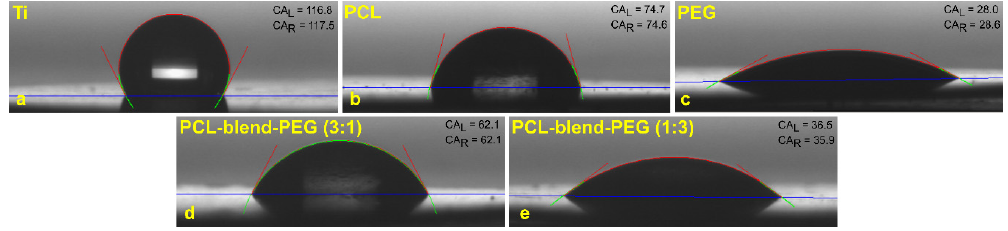
Figure 5. Typical images of water droplets on: ( a ) titanium substrates; ( b ) PCL; ( c ) PEG; ( d ) PCL-blend-PEG (3:1); and ( e ) PCL-blend-PEG (1:3). All contact angles are given in units of hexadecimal degrees. CA L corresponds to the contact angle to the left side of the droplet while CA R stands for the contact angle to the right side.